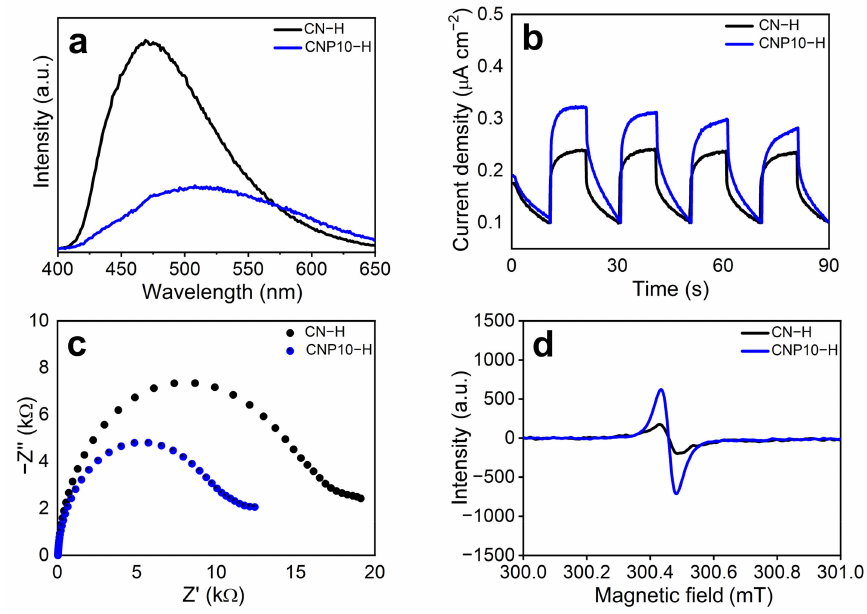
Figure 8. ( a ) Photoluminescence (PL) spectra, ( b ) photocurrent response, ( c ) Nyquist plots, and ( d ) room-temperature EPR spectra of CN-H and